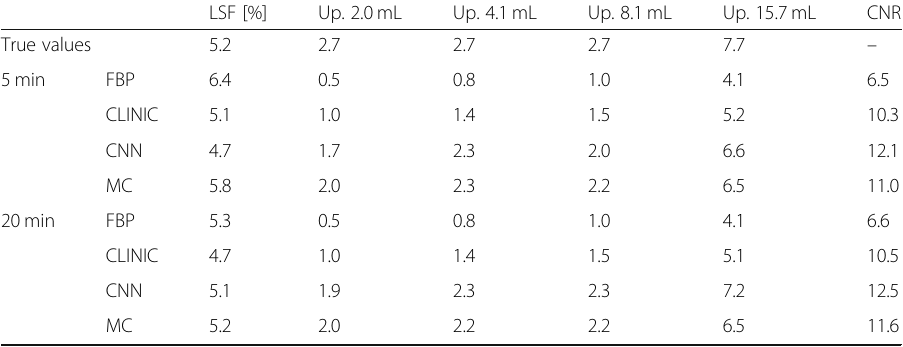
Table 1 Lung shunting fraction, uptake ratio for the spheres, and contrast-to-noise ratio for the four reconstruction methods and two scan times, together with the values as configured in the phantom LSF [%]